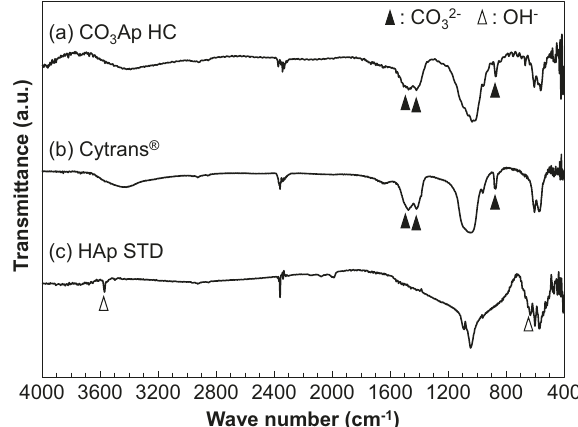
Fig. 4 XRD patterns. CO 3 Ap HCBs (HC) ( a ), Cytrans Granules ® (Cytrans ® ; CO 3 Ap granules) ( b ), and HAp standard substance (STD) ( c ). Circles indicate the apatite diffraction peaks